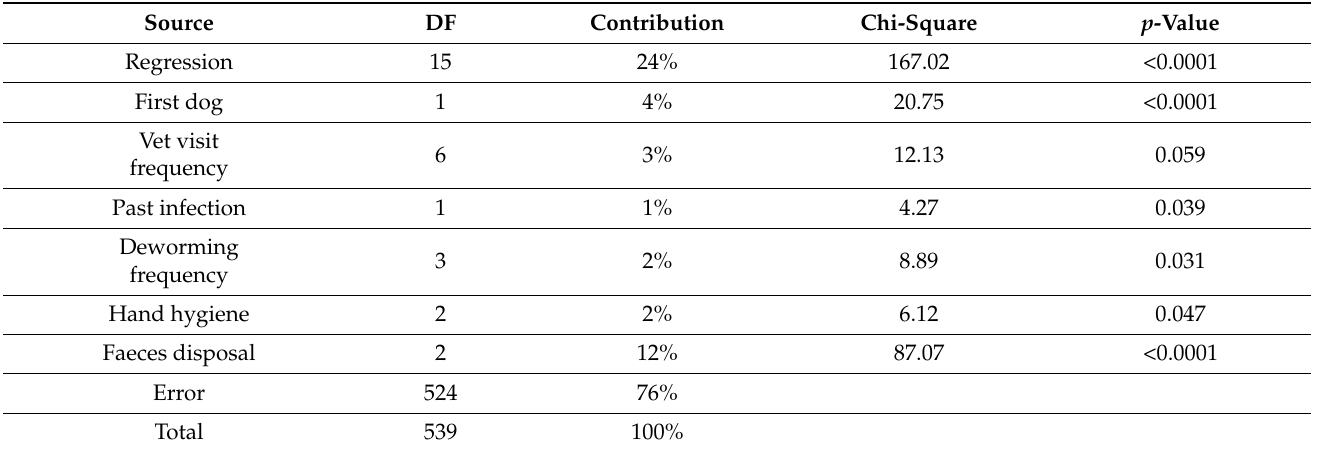
Table 4. Binary logistic regression analysis for factors that differed for owners from rural or urban localities.